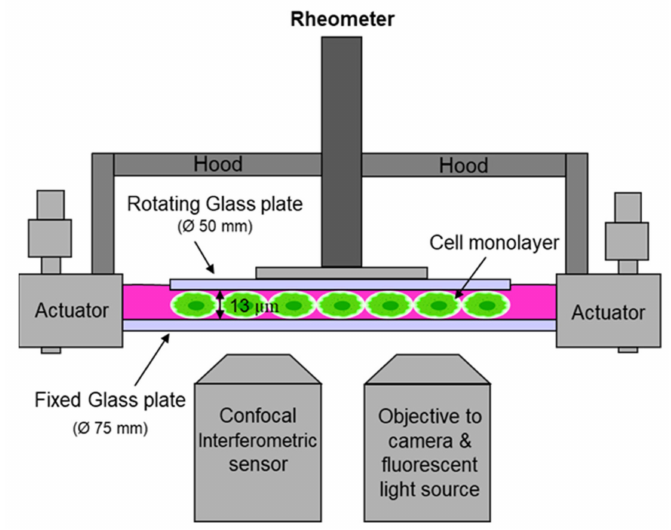
Figure 1. Sketch of the narrow-gap